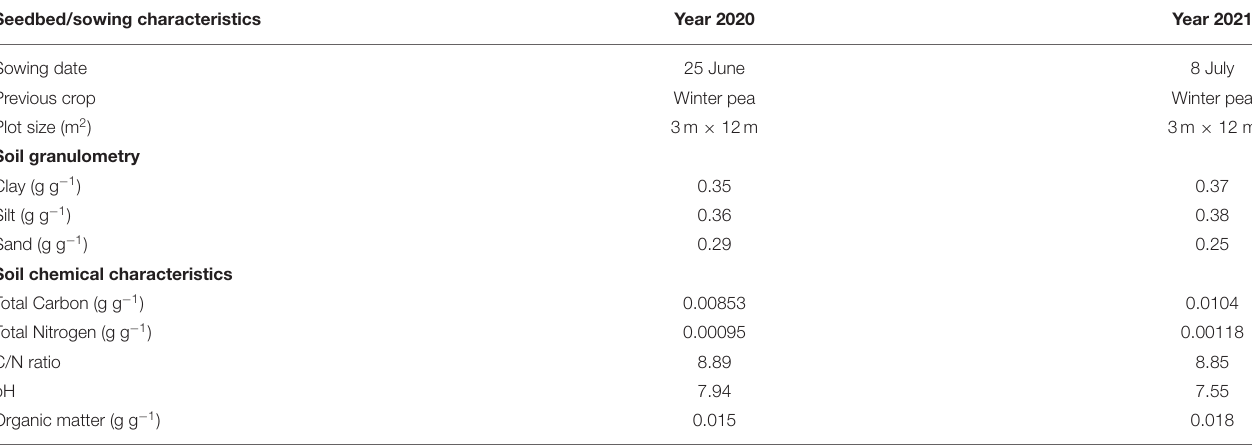
TABLE 2 | Seedbed and sowing conditions of hybrid oilseed varieties of sunflower for the two consecutive years, 2020 and 2021 at the Auzeville experimental station. Seedbed/sowing